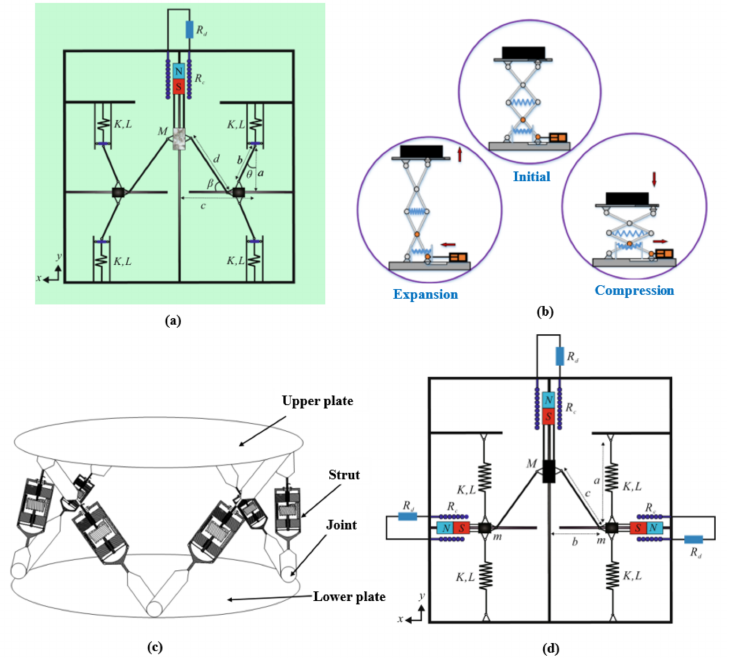
Figure 12. QZS-based SVIEH by using ( a ) the HQZS structure, ( b ) X structure electromagnetic wave energy converter, ( c ) the Stewart Platform, and ( d ) the multistable and multidirectional